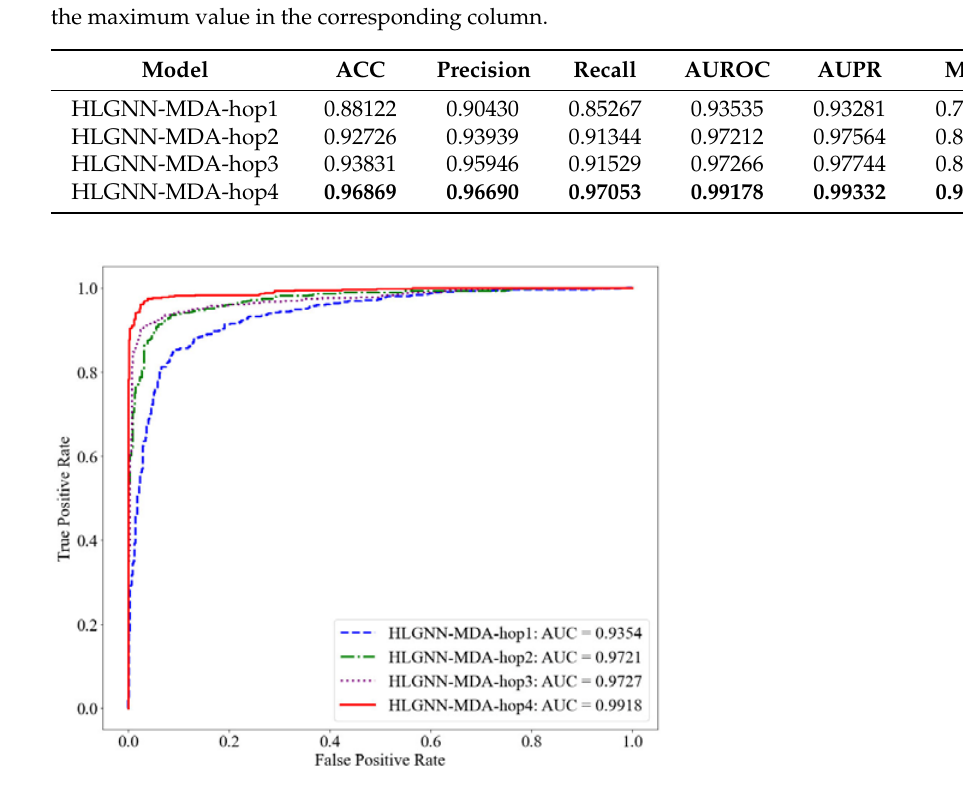
Figure 6. ROC curve of HLGNN-MDA in different enclosing subgraphs.